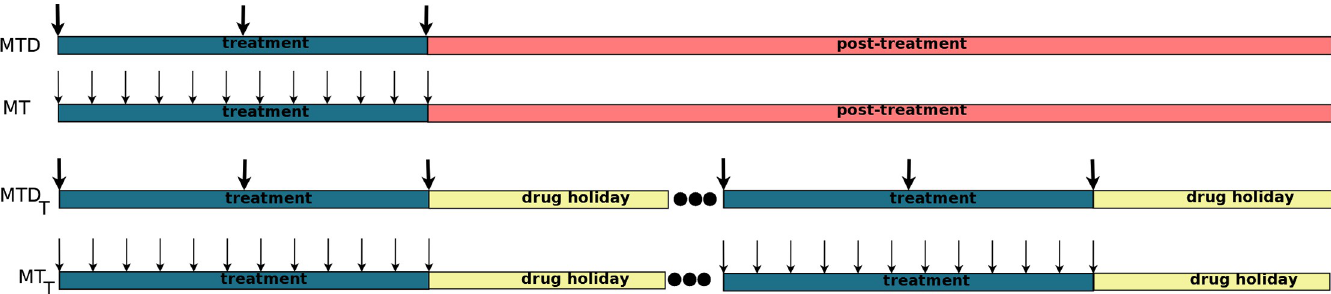
Fig 5. Treatment schedules considered in the palliative treatment of advanced non-resectable NSCLC patients.